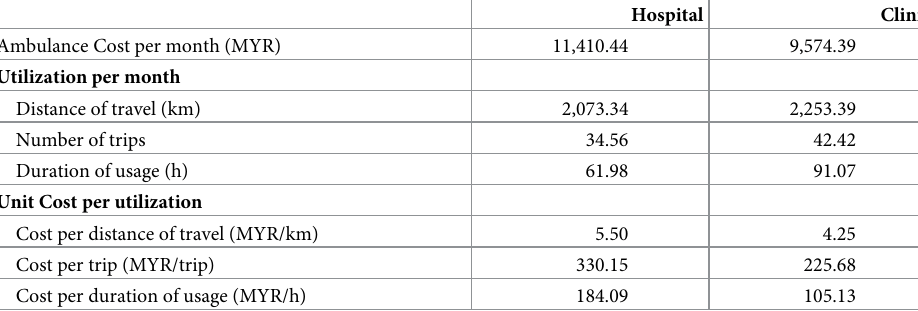
Table 5. Cost by ambulance